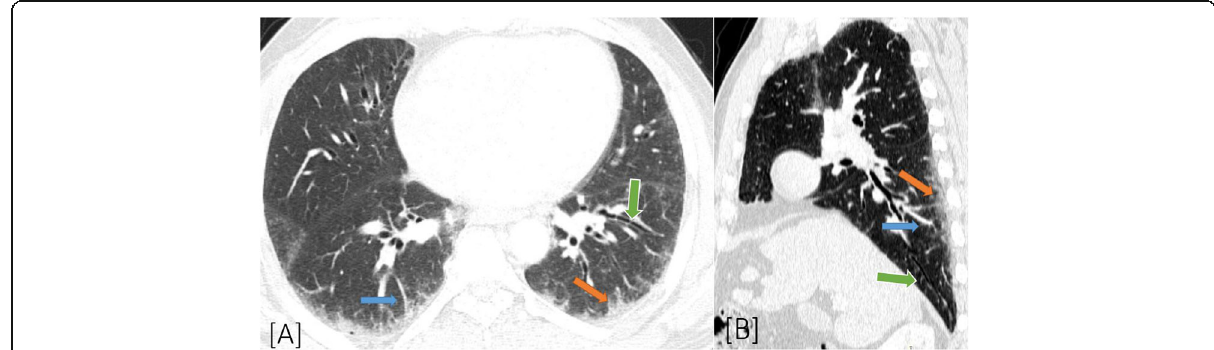
Fig. 9 A 47-year-old patient with active hepatitis complaining from progressive dyspnea with mild degree of restrictive PFT. a , b Axial and sagittal HRCT chest (lung window) showing sub-pleural GGO (orange colored arrow) with mild reticular thickening (blue colored arrow) and traction bronchiolectasis (green colored arrow). Fibrosing NSIP pattern